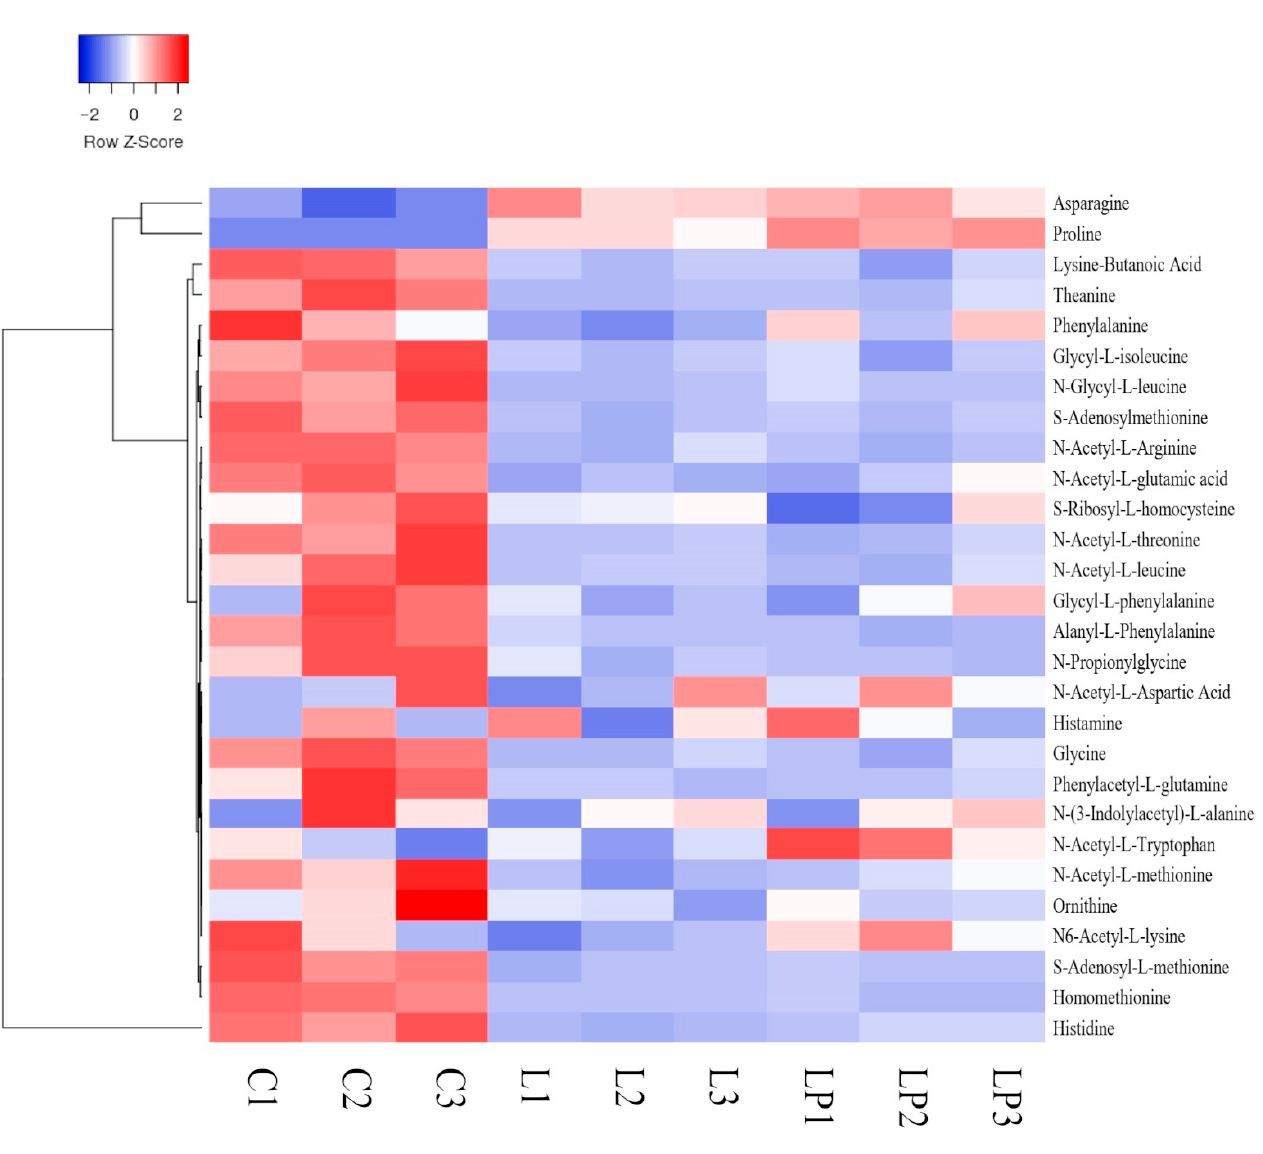
Figure 13. Heatmap and dendrogram of amino acids metabolites in embryos of maize under exoge- nous proline and low-temperature stress treatments.